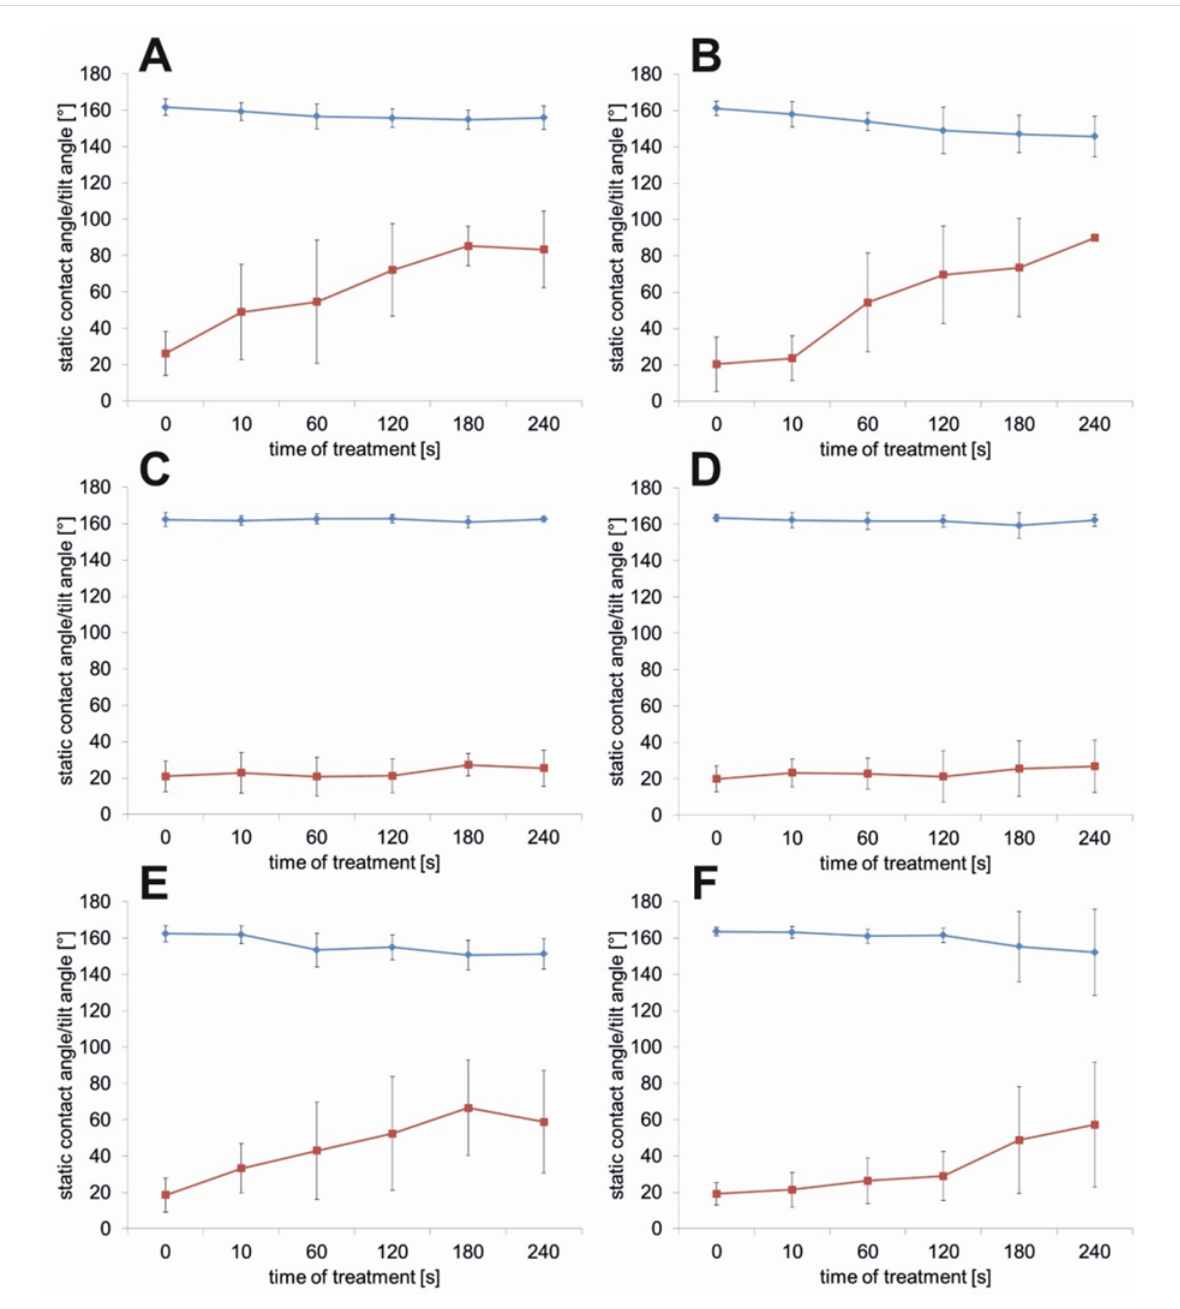
Figure 4: Contact angles (blue lines) and tilting angles (red lines) of the leaf surfaces of Glycine max L. after applying 20 µL of an aqueous surfactant solution (1 g/L) of SBO 10 (A), XP ED 00-75 (B), XP ED 28-11 (C), XP ED 28-12 (D), XP ED 28-13 (E), and XP ED 28-14 (F). Surfactants and leaf surfaces where in contact for 10, 60, 120, 180 and 240 s. Before the CAs and TAs were measured, the leaves were rinsed with pure water. The time zero represents the values for leaves which were in contact with water as a control. Values are given as the mean value of n = 10 ± standard devia-